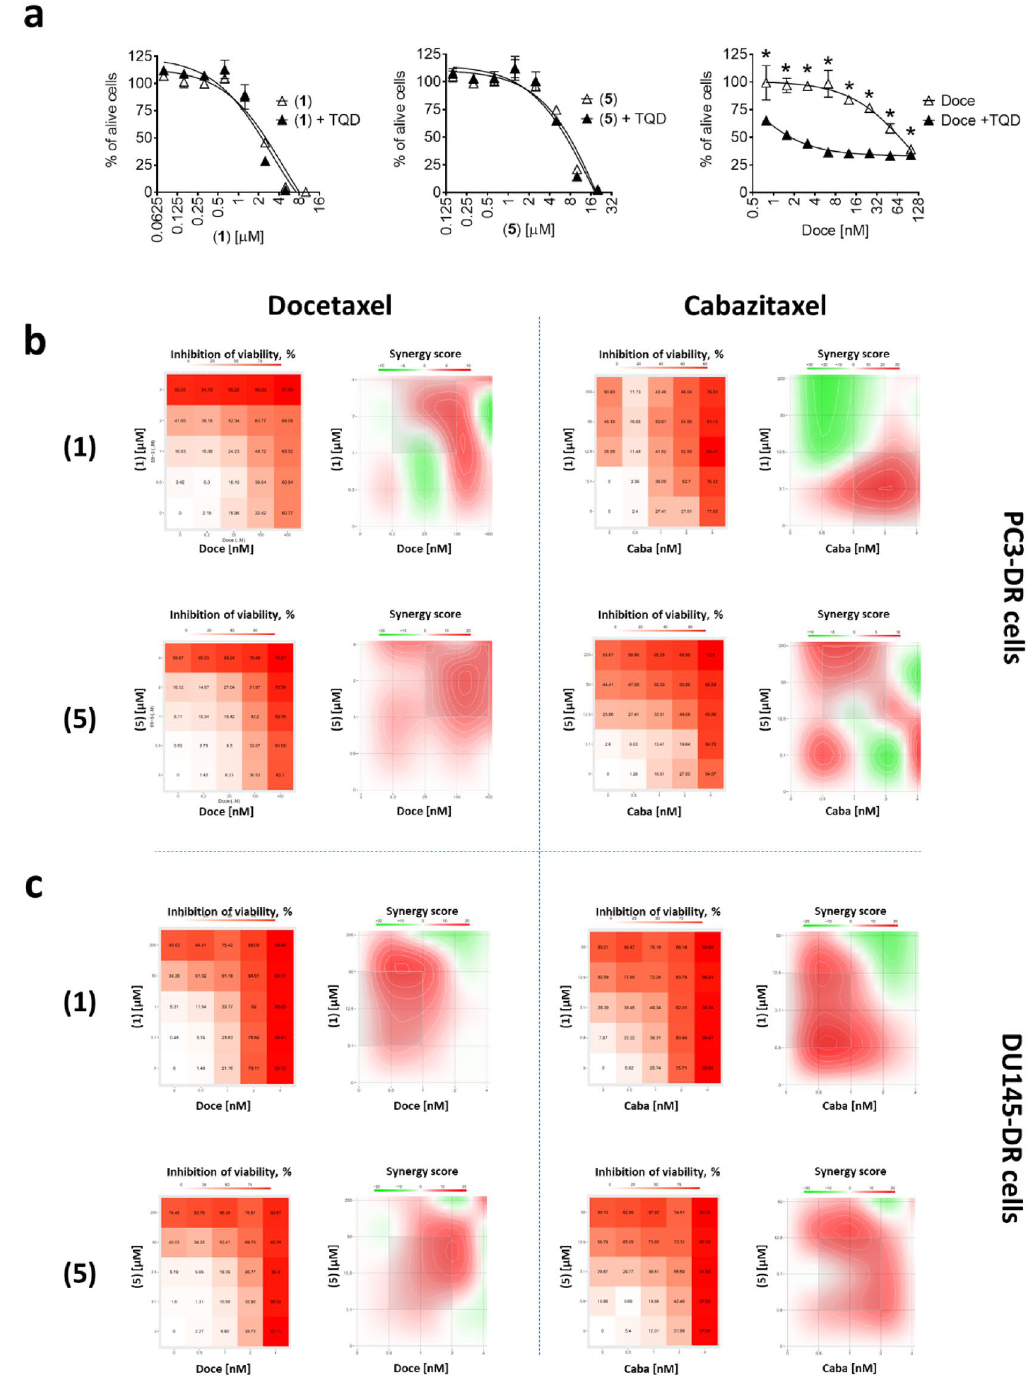
Figure 6. Effects of the drug combinations on viability of PC3-DR and DU145-DR cells. ( a ), PC3-DR cells were pretreated with tariquidar (TQD, 50 nM) for 30 min and then co-treated with the indicated drugs for 48 h. ( b , c ), PC3-DR ( b ) and DU145-DR ( c ) cells were co-treated with docetaxel (Doce) or cabazitaxel (Caba) in combination with diterpenes 1 or 5 at the indicated concentrations. Cellular viability was measured using MTT assay. The cytotoxicity heat-maps (viability inhibition) as well as synergistic/additive/antagonistic effects of drug combinations were analyzed and visualized using SynergyFinder 2.0 software (https:// syner gyfin der. fimm. fi/) using a ZIP algorithm ( b , c ). Red areas indicate synergistic effects of the drug combinations. * p < 0.05, one-way ANOVA